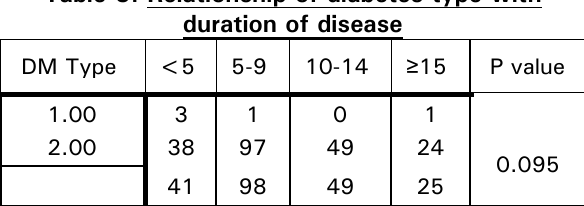
Table 5: Relationship of diabetes type with